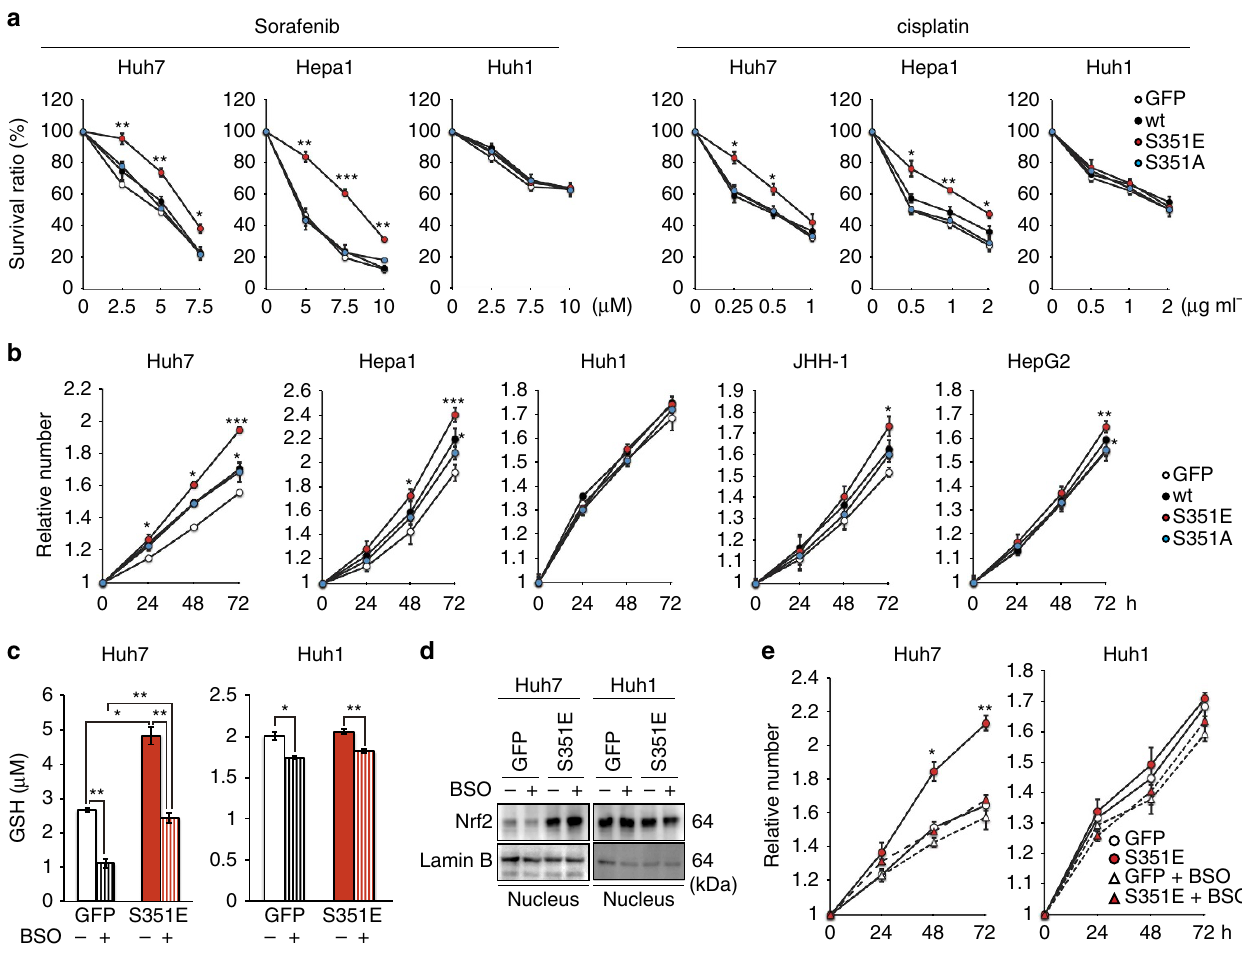
Figure 5 | Tolerance to anti-cancer drugs and proliferation potency of HCC cells expressing phospho-mimetic p62. ( a ) Effect of phospho-mimetic p62 on anti-cancer drug resistance. The indicated HCC cells were infected with adenovirus for GFP, wild-type p62 or its mutants for 60h. Thereafter, the cells were treated with sorafenib or cisplatin at the indicated concentration for 48h, and the survival ratio was determined. The experiments were performed three times. Data represent means ± s.e. * P o 0.05, ** P o 0.01, *** P o 0.001 as determined by the Welch t -test. ( b ) Effect of phospho-mimetic p62 on proliferation. The indicated HCC cells were infected with adenovirus for GFP, wild-type p62 or its mutants. Proliferation was measured from 60h after infection. Initial cell numbers were normalized to 1. The experiments were performed three times. Data represent means ± s.e. * P o 0.05, ** P o 0.01, *** P o 0.001 as determined by the Welch t -test. ( c ) Glutathione levels in the presence or absence of BSO. The indicated HCC cells were infected with adenovirus expressing S351E. At 60h after infection, the cells were cultured in the presence or absence of BSO for 72h, and then glutathione was quantitated. The experiments were performed three times. Data represent means ± s.e. * P o 0.05, ** P o 0.01, *** P o 0.001 as determined by the Welch t -test. ( d ) Immunoblot analysis. Indicated HCC cell lines were cultured as described in c , and their cytosolic and nuclear fractions were prepared and subjected to immunoblot analysis with the specified antibodies. Data were obtained from three independent experiments. ( e ) Proliferation in the presence or absence of BSO. The indicated HCC cells were infected with adenovirus for S351E. At 60h after infection, the cells were cultured in the presence or absence of BSO for the indicated time, and proliferation was measured. Initial cell numbers were normalized to 1. The experiments were performed three times. Data represent means ± s.e. * P o 0.05, ** P o 0.01, *** P o 0.001 as determined by the Welch t -test. We used mouse p62 constructs in these